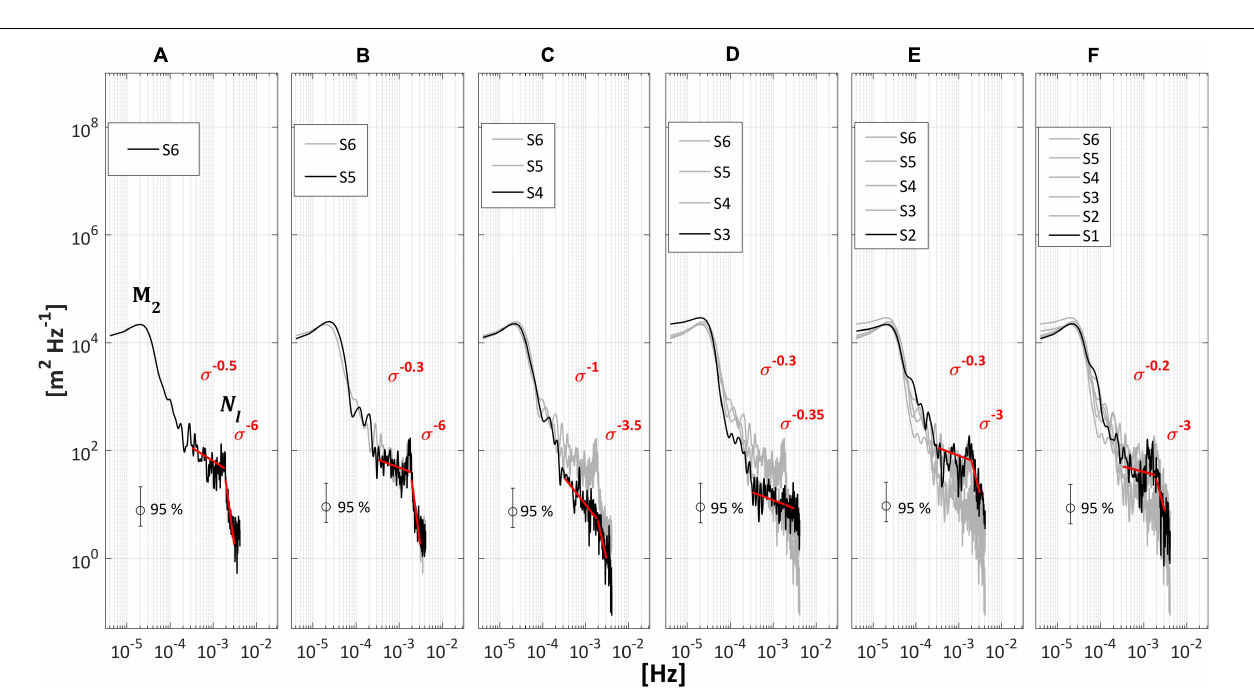
Zimmerman, 2008). Due to the fact that the wave amplitude is directly proportional to its characteristic nonlinear steepening (Vlasenko et al., 2005), the tidal bore in S6 had further dispersive